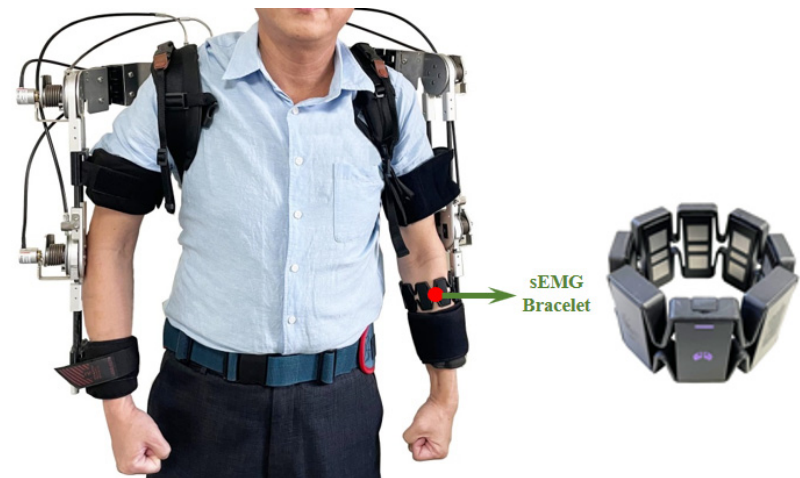
Figure 27. sEMG bracelet worn on the forearm to detect motion intention.